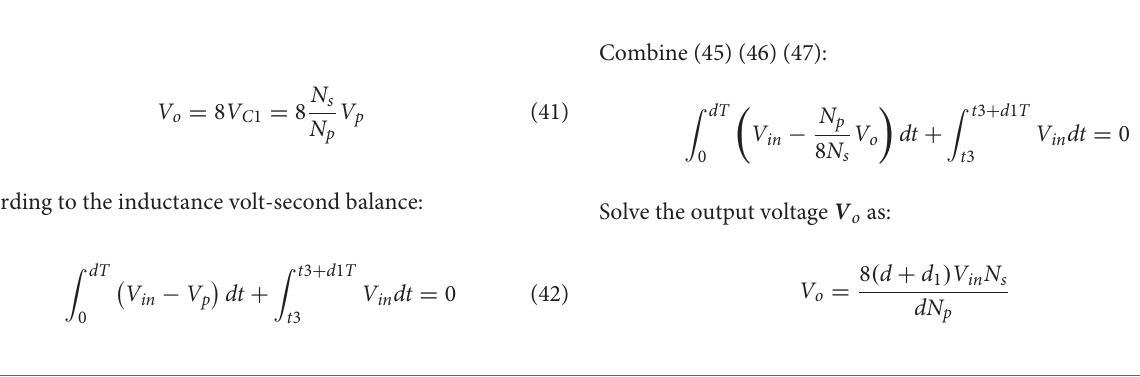
FIGURE 14 | Electric field distribution. (A) Three-dimensional electric field distribution. (B) The contour electric field